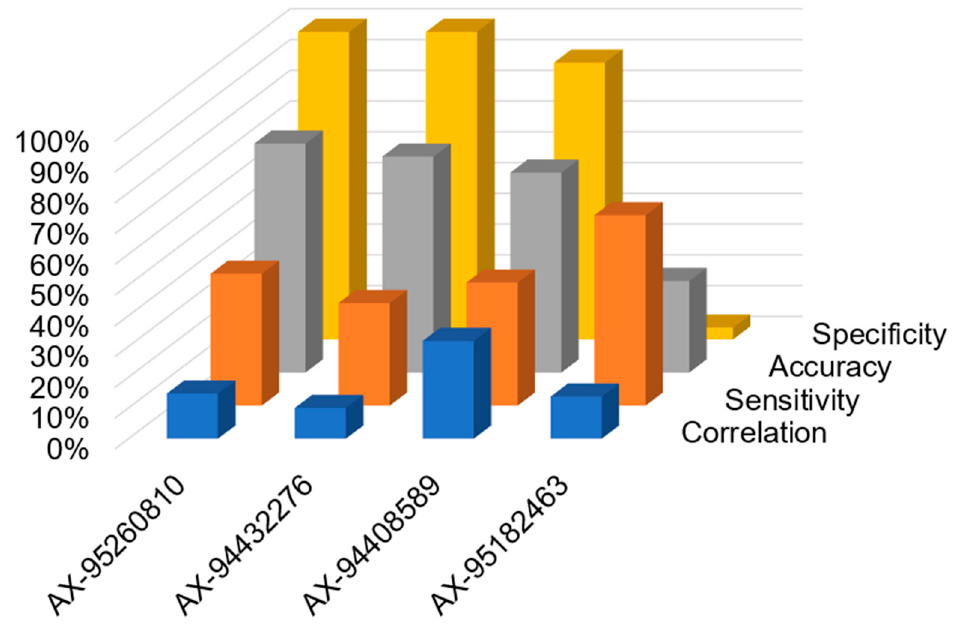
Figure 6. Kompetitive Allele Specific PCR ( KASP) markers validation on an independent set of 94 elite lines of ICARDA tested under severe heat for grain yield and biomass. Correlation was measured between the BLUE for grain yield recorded along the Senegal River and the haplotype score. Accuracy, sensitivity, and specificity where determined using only the top 20 and worst 20 lines. AX-95260810 and AX-94432276 tag QTL.ICD.Heat.08, AX-95182463 tags QTL.ICD.Heat.09, AX-94408589